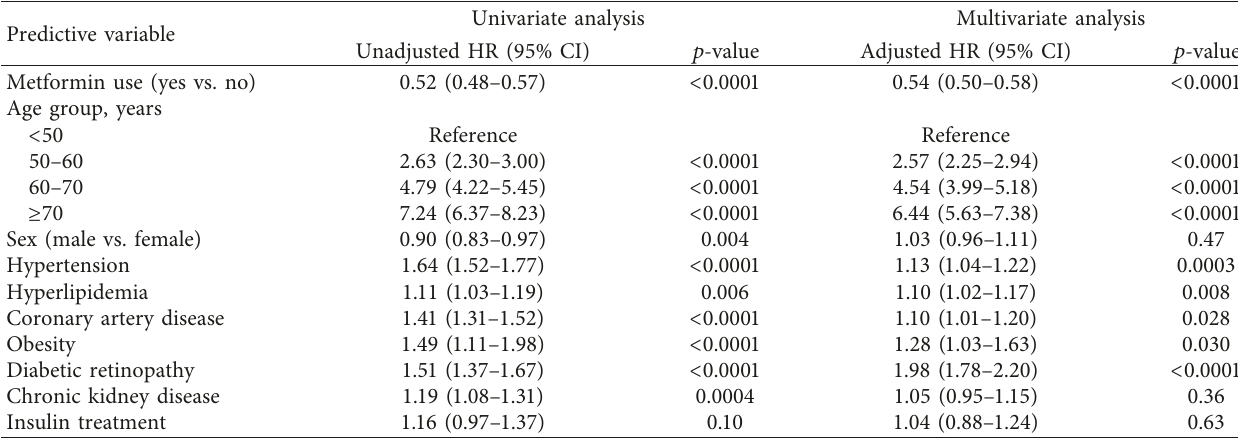
Figure 2: Kaplan–Meier curves for AMD among the metformin group and the nonmetformin group. The black line represents the metformin group and the gray line represents the nonmetformin group. AMD: age-related macular degeneration. Table 2: Risk factors for AMD in metformin users and